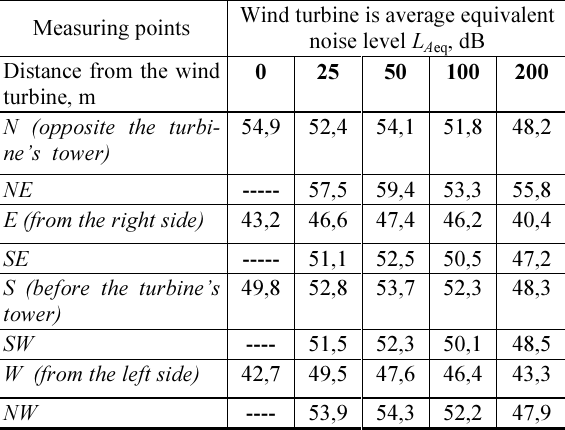
Table 2. Wind power plant’s average equivalent noise level L Aeq measuring results